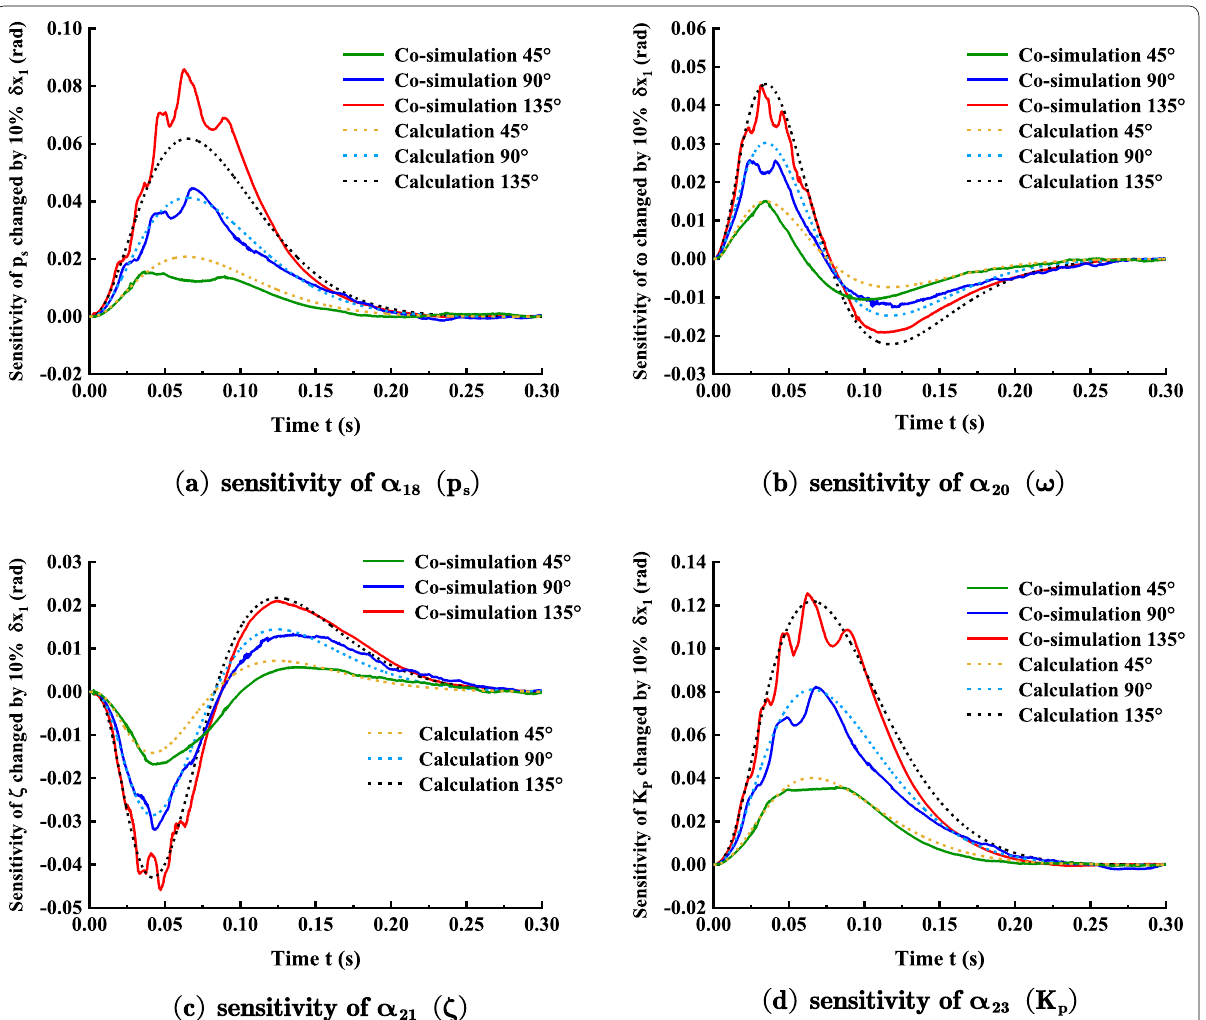
Figure 12 Comparison of theoretical and co-simulation values: change in rotation angle corresponding to each parameter under “no-load”